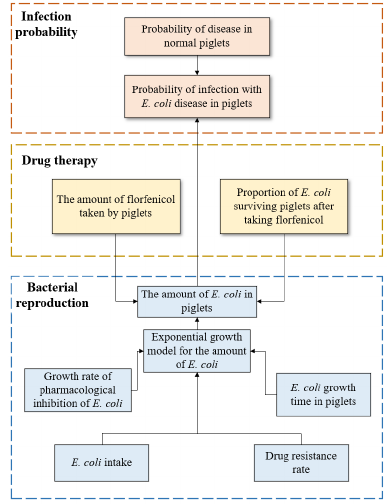
Figure 1. The framework of the second-order Monte Carlo